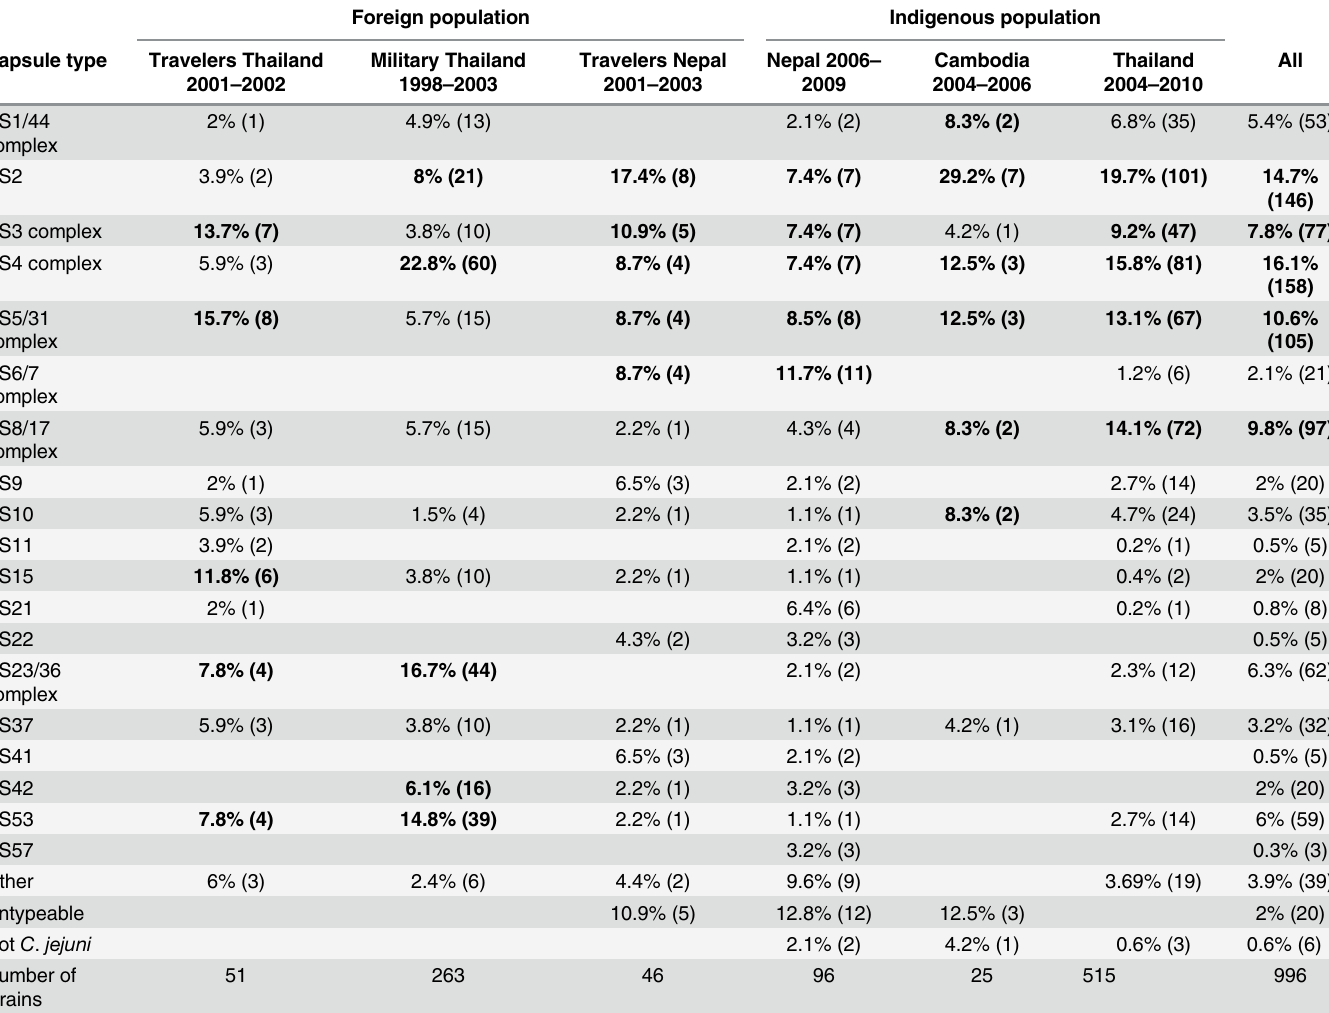
Table 5. Capsule multiplex PCR results among all C . jejuni isolates from different population group from South and South-East Asia. In bold are the five most prevalent CPS types in their respective group. Number in parentheses represent the number of strain in the